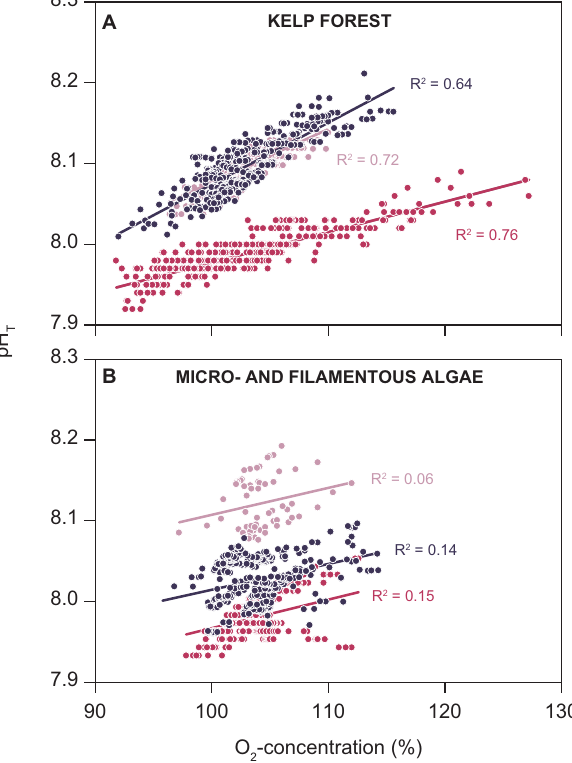
Figure 6. pH vs. O 2 concentration for three parallel deployments (#1–3 shown by increasing colour intensity) in subtidal habitats colonized by kelp forests (top panel) or microalgae/scattered fil- amentous algae (bottom panels) in Kobbefjord, Nuuk, August– September 2013. Each deployment represents 10min loggings by multiloggers (Hydrolab) over ca. two diurnal cycles. Linear fits and coefficients of determination are